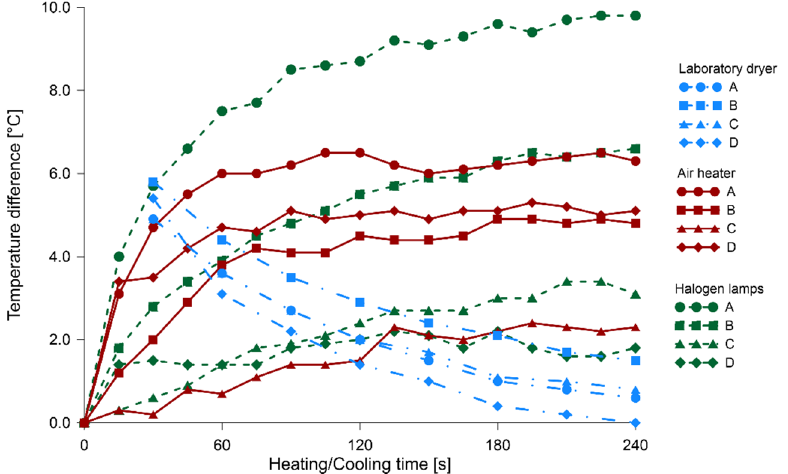
Figure 9. The relationship between heating/cooling time and temperature difference of solid spruce wood and knots.